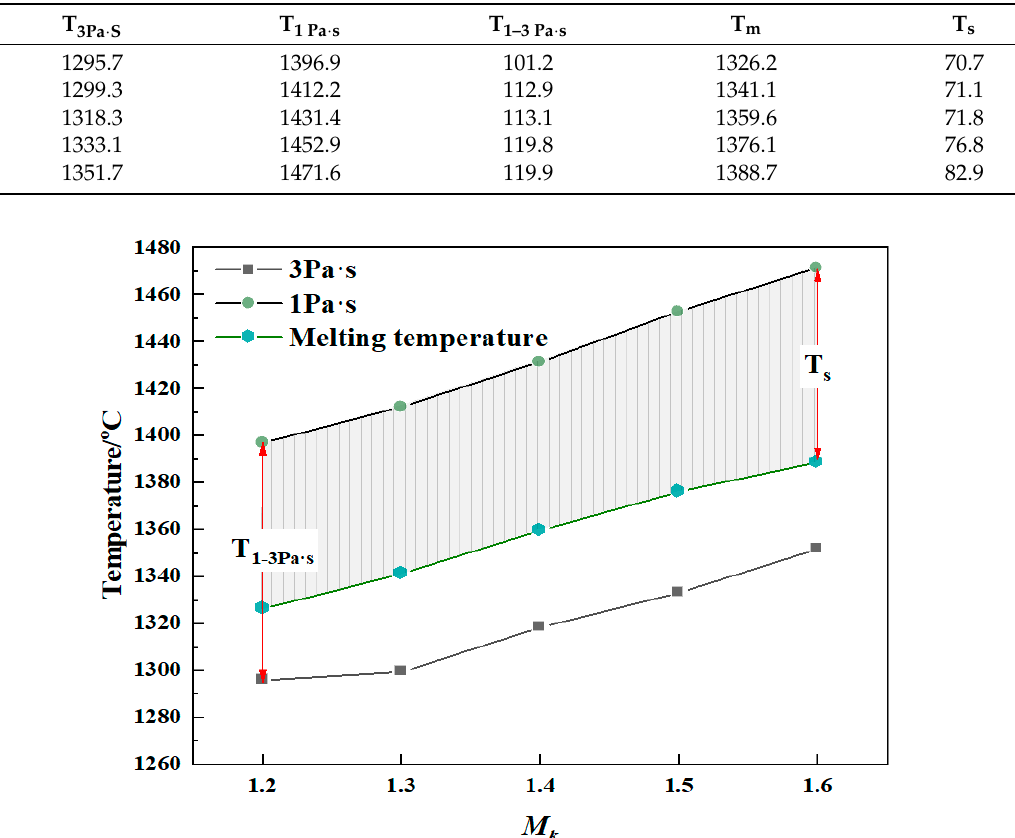
Table 3. Suitable fiber-forming temperature range of modified blast furnace slag in the viscosity range of 1–3 Pa·s/°C.